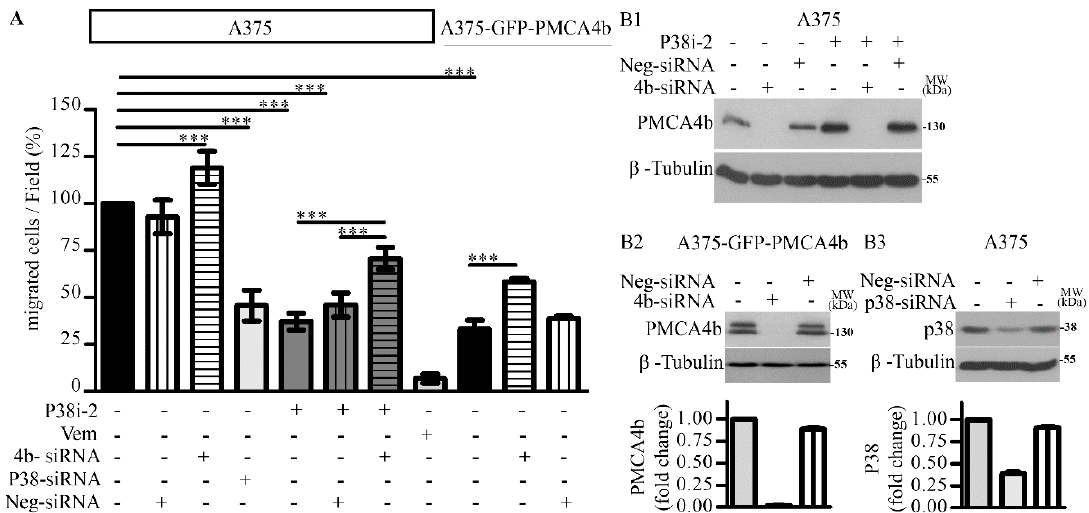
Figure 6. P38 inhibitor decreased cell migration at least partly through PMCA4b. ( A ) A375 and A375-GFP-PMCA4b cells were treated with 10 µ M SB20290 and 0.5 µ M vemurafenib for 48 h, with or without the siRNA reagents (see below). After treatments cells were harvested, counted and seeded in the upper Boyden chamber. Fibronectin was used as an attractant in the lower chamber. After 3 h incubation migrated cells were fixed and stained using Toluidine blue. Images ( n = 4) were taken as representative fields of view from the bottom of the membrane. The bar graphs indicate the average number of migrated cells per field. Data are means ± SD of two independent experiments. ( B1 ) A375 cells were transfected with PMCA4b or control siRNAs and incubated for 72 h. SB202190 was added alone or 24-h post-transfection, as indicated in the figure. ( B2 ) A375-GFP-PMCA4b cells were transfected with PMCA4b and control siRNAs and incubated for 72 h. ( B3 ) A375 cells were transfected with p38 MAPK or control siRNAs incubated for 72 h. Protein expression was analyzed by Western blotting using anti-PMCA4b antibody JA3. Western blots are representative of three independent determinations.